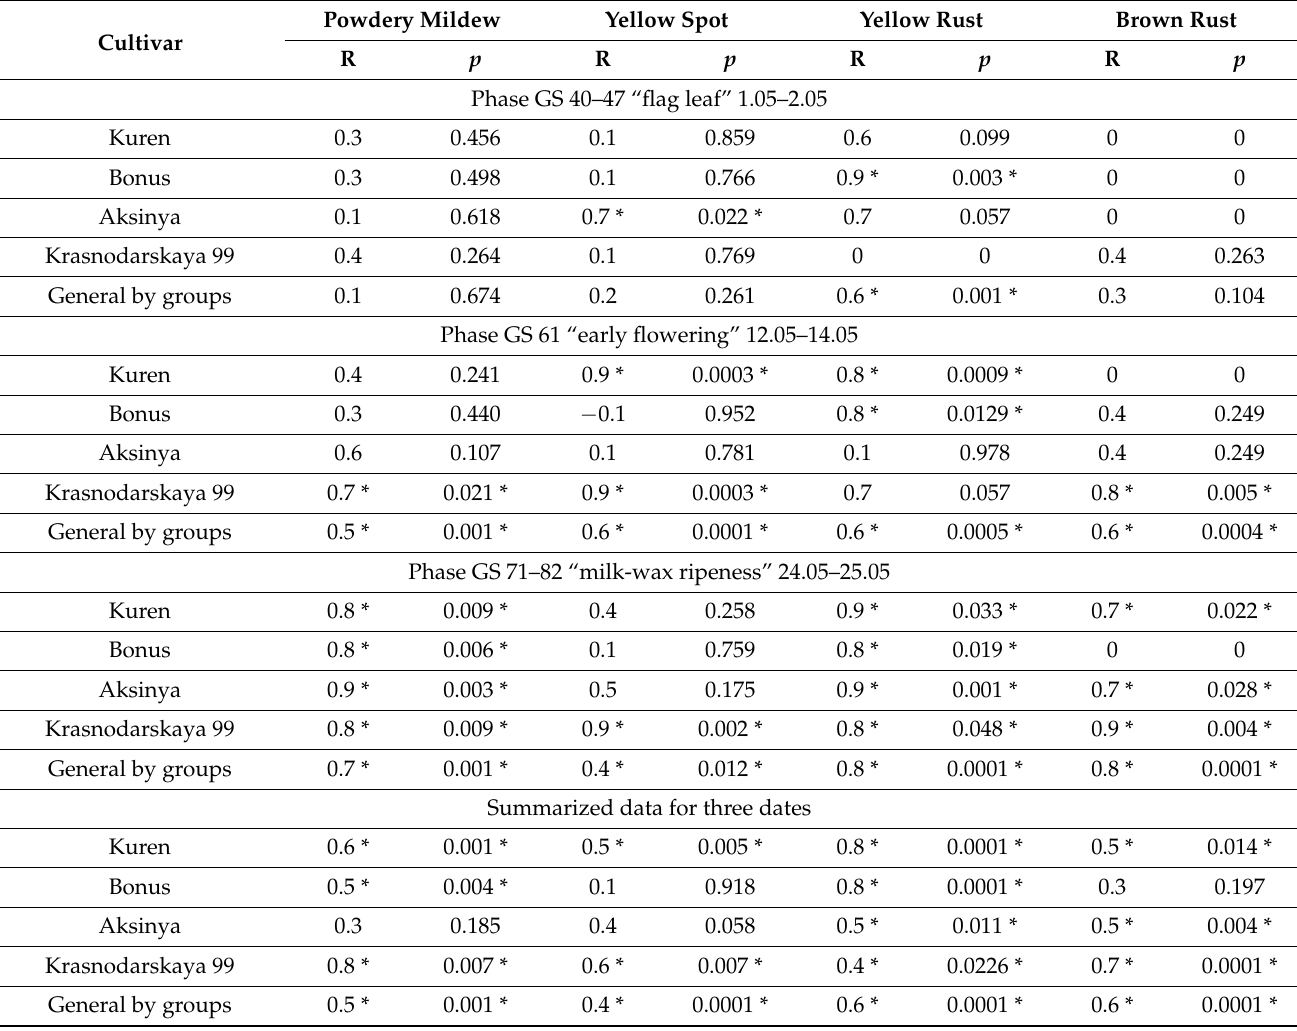
Table 3. The results of the correlation analysis of the relationship between the number of spores caught using a spore trapping device and the degree of disease development in wheat crops for three growing seasons from 2019 to